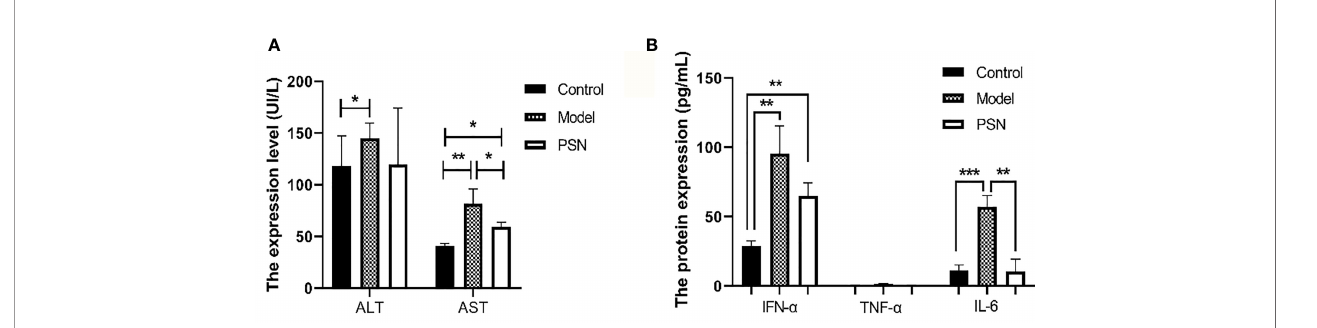
FIGURE 10 | ELISA tests for the expression of transaminases and cytokines in mices's serum after PSN treatment. (A, B) The relative expression of transaminases ALT and AST, cytokines IFN- a , TNF- a , and IL-6. Data are representative of three independent experiments with n = 8 mice per group. * P < 0.05, ** P < 0.01, *** P <